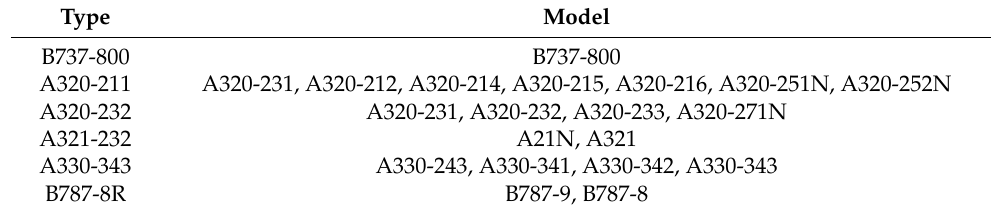
Table A1. Aircraft model at BIA [29].